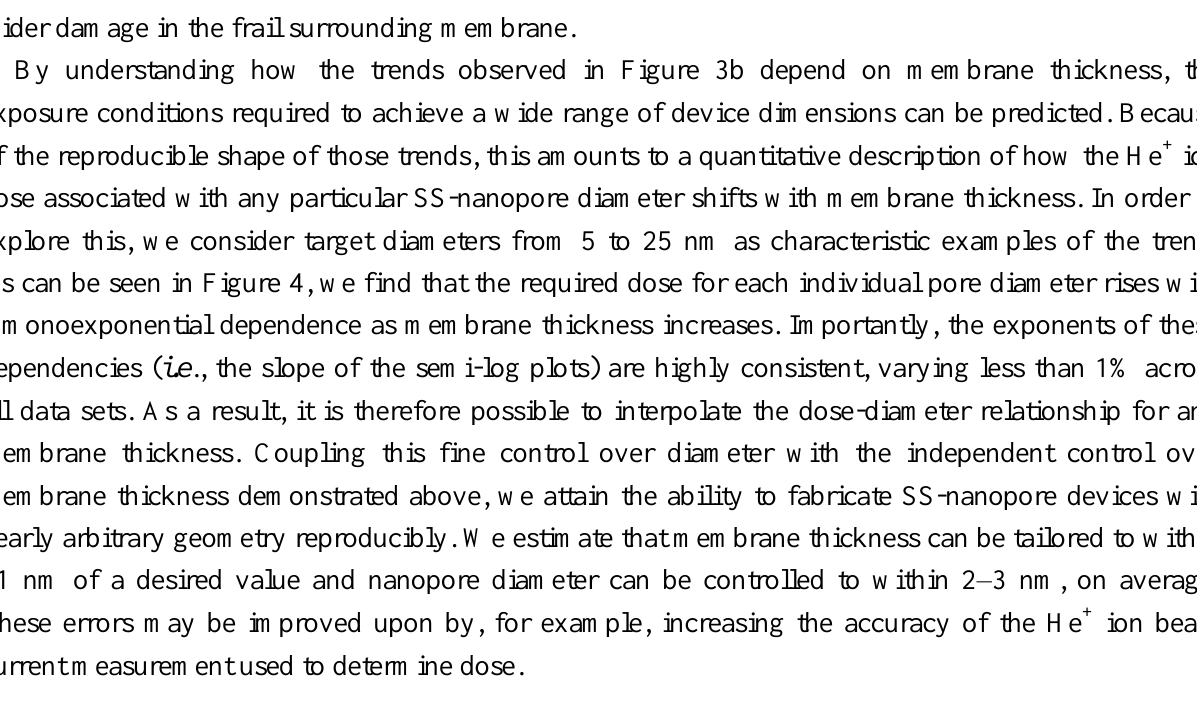
Figure 4. Pore expansion dynamics vary predictably with membrane thickness. The dose required to achieve a target nanopore diameter plotted as a function of membrane thickness. The datasets are for pore diameters (from bottom to top) of 5 (black circles), 10 (red squares), 15 (orange upward triangles), 20 (green downward triangles), and 25 (blue diamonds) nm, respectively. The dose required for all representative pore diameters varies as a monoexponential with membrane thickness. The slopes agree within less than